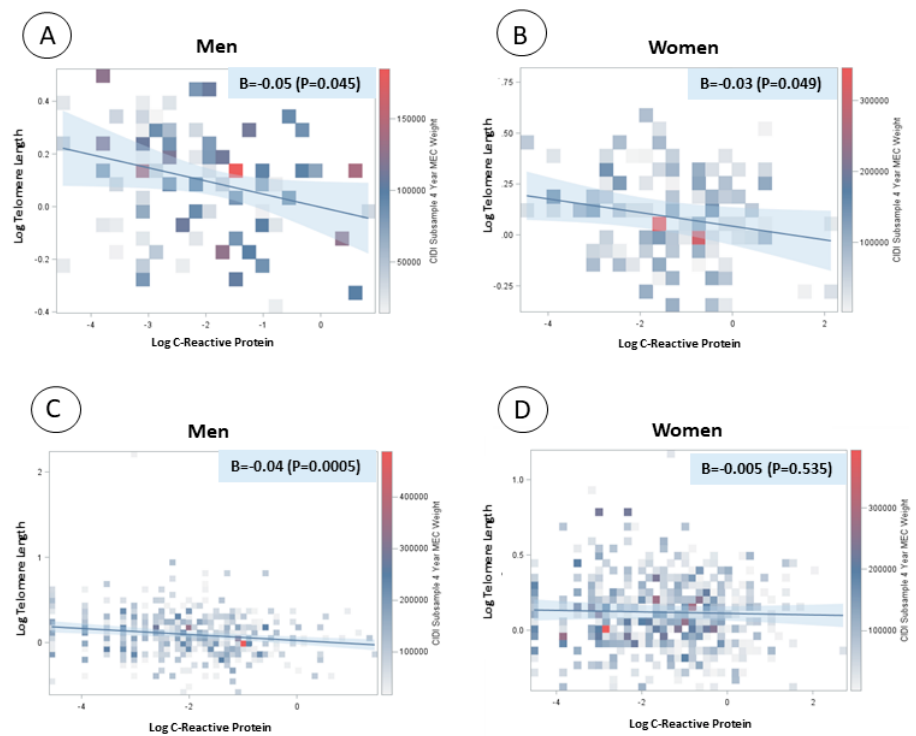
Figure 1. Linear regression models between log-transformed C-reactive protein and log-transformed telomere length by sex and depression status. ( A ) Men with major depression or depressed affect; ( B ) women with major depression or depressed affect; ( C ) men without depression; and ( D ) women without depression.